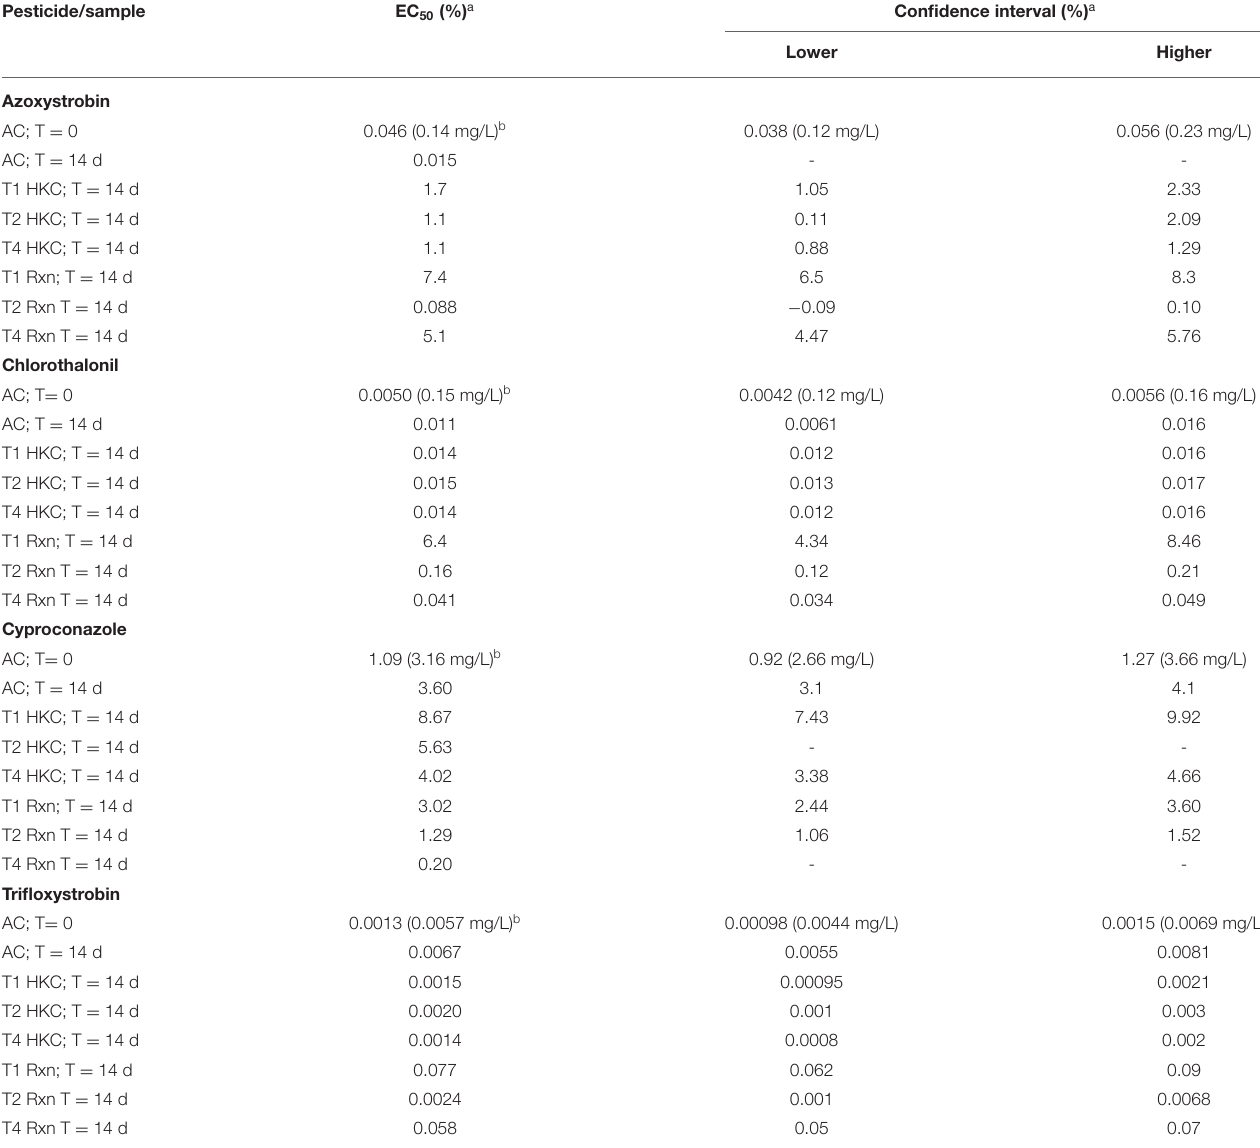
TABLE 1 | Ecotoxicological evaluation of pesticides at initial working concentrations (abiotic control at T = 0 d) and after 14 d of treatment (AC, abiotic control; HKC, heat-killed control; Rxn, viable fungal biomass), according to immobilization tests in D. magna .